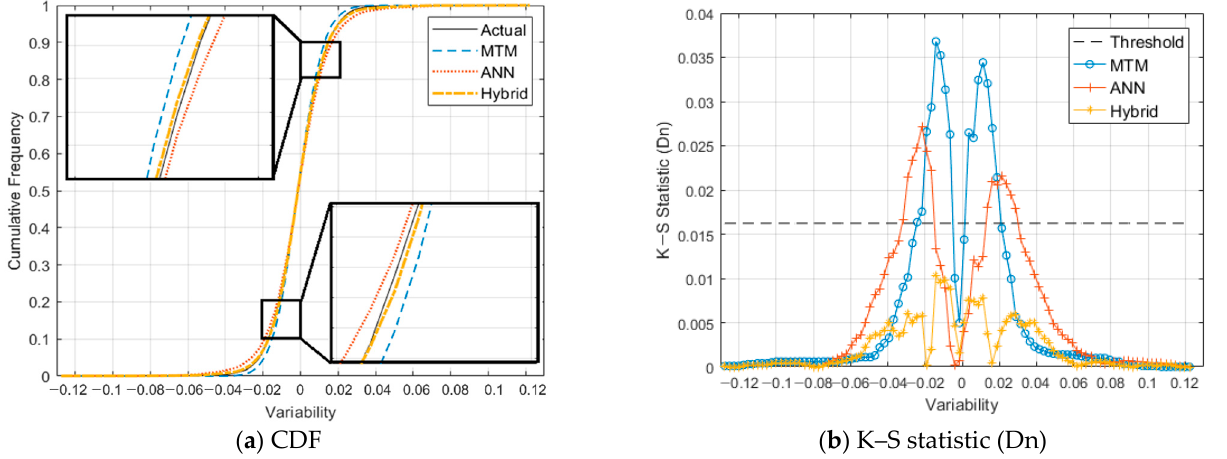
Figure 11. Daily 1-min load profiles of Customer A on the measurement and estimation results of the MTM, ANN, and hybrid models.